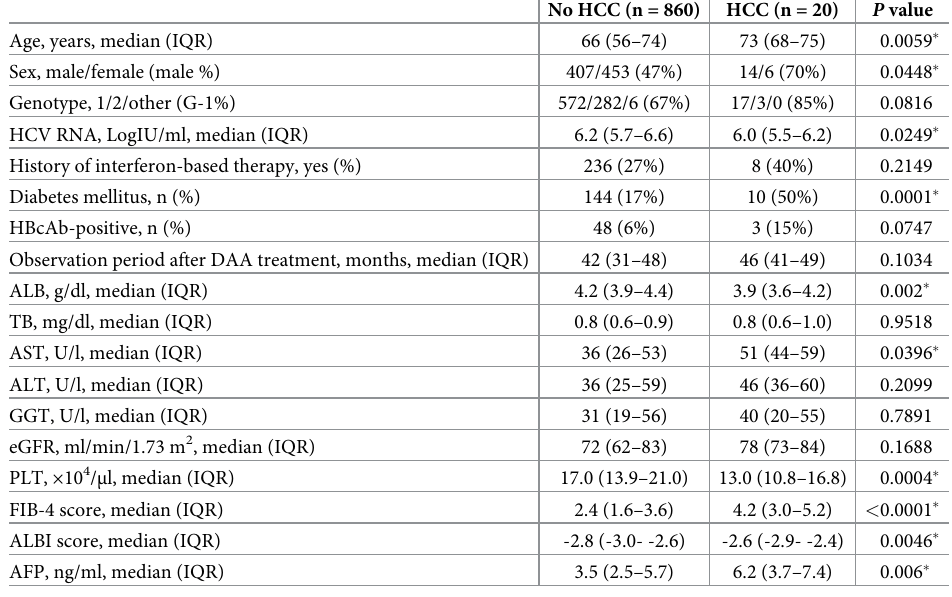
Table 2. Pretreatment factors associated with the development of hepatocellular carcinoma after DAA treatment in HCV-positive patients without cirrhosis.